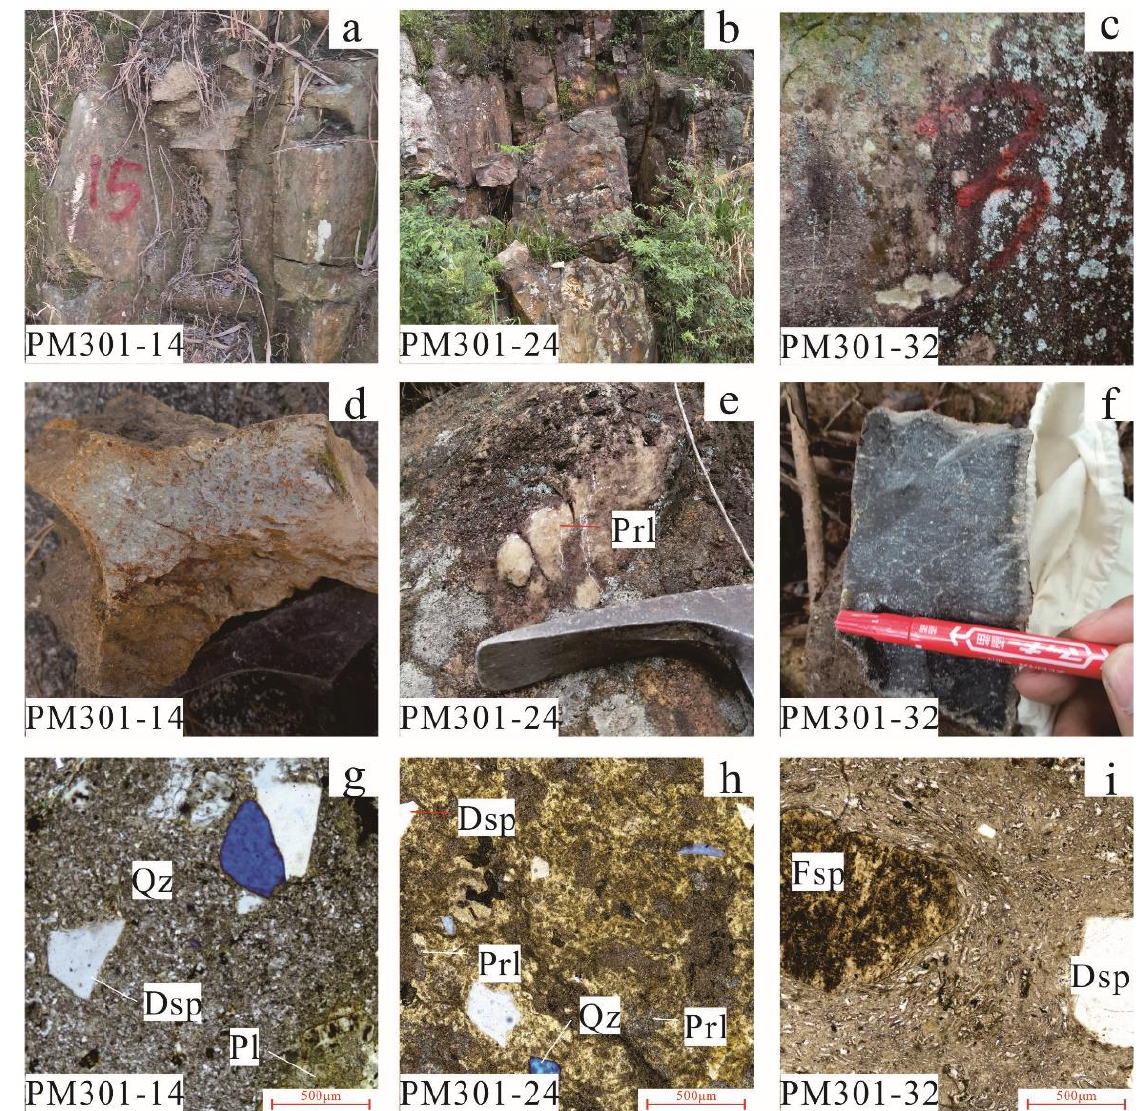
Figure 4. Representative photographs of unaltered rhyolitic tuff (PM302-14 and PM302-32) and rhyolitic tuff with hydrothermal alteration (PM302-24). ( a – c ) The outcrop in the route of geological field survey ( b – f )-collected rock for geochemical analysis, ( g – i ); transmitted-light photomicrographs of the collected sample. Note: quartz = Qz; pyrophyllite = Prl; diaspore = Dsp; plagioclase = Pl; feldspar = Fsp.